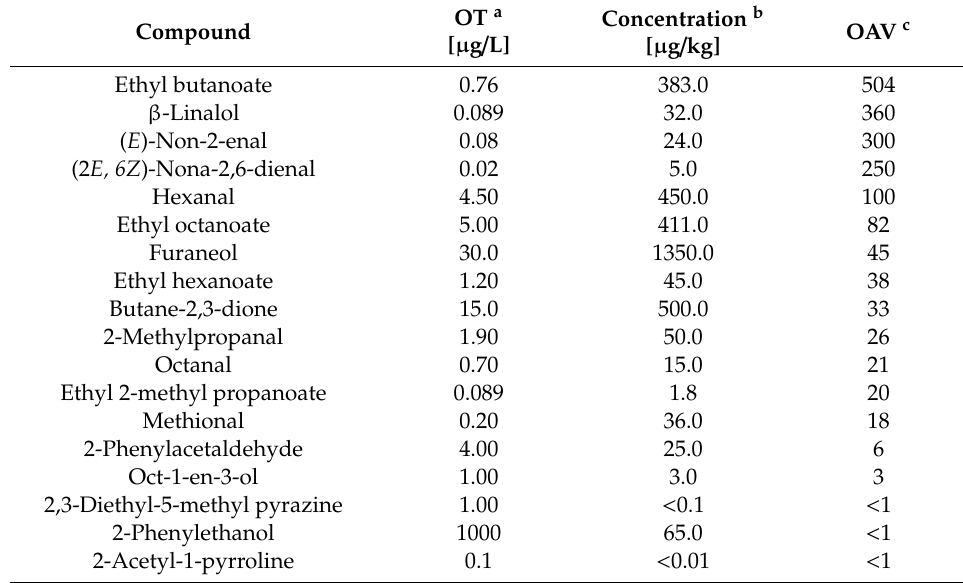
Table 2. Concentration, odor thresholds, and odor activity values of aroma active compounds of cape gooseberry